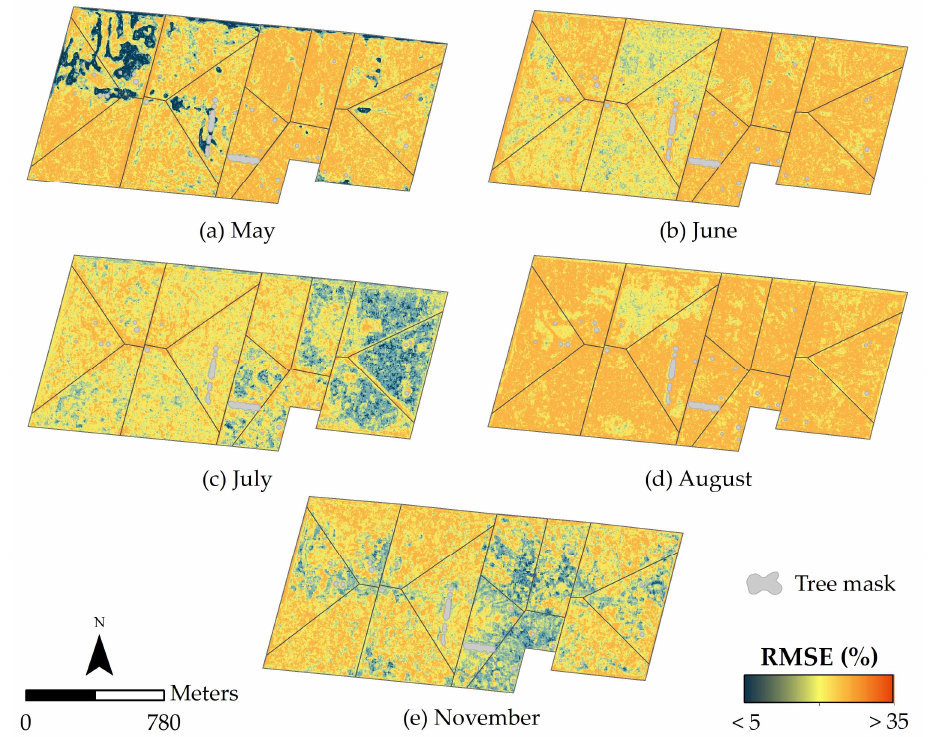
Figure 10. Estimated relative RMSE uncertainty (in %) maps for the aboveground biomass (AGB) estimation in the months of May ( a ), June ( b ), July ( c ), August ( d ), and November ( e ).